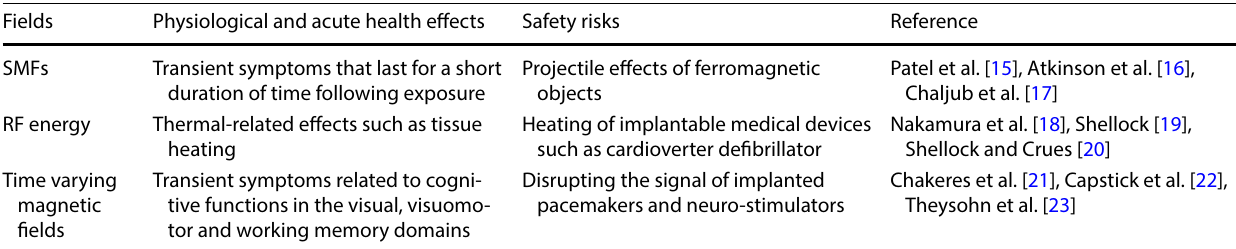
Table 6 Comparison of previous studies on MRI health and safety risks